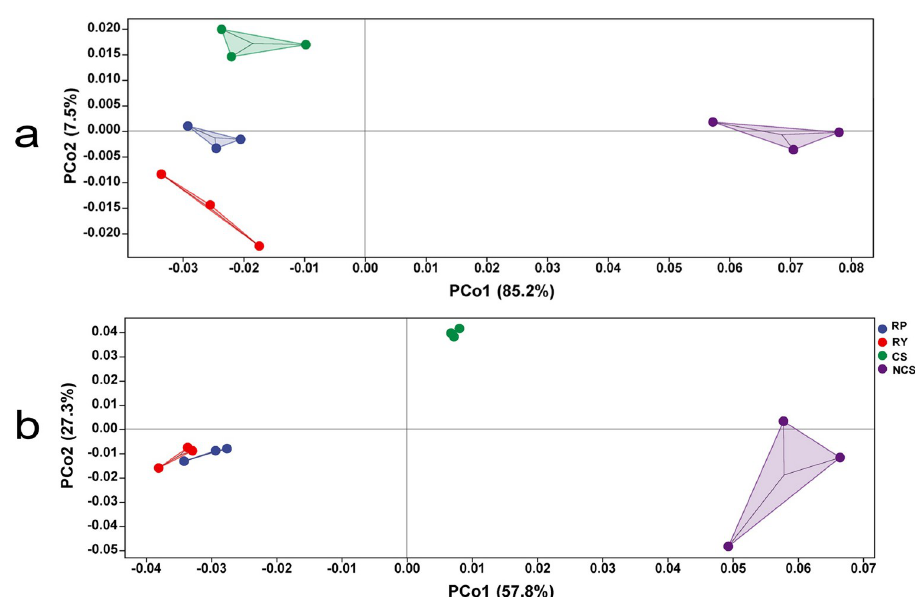
Fig 5. PCoA of fungi (a) and bacteria (b). Using the normalized functional unit abundance table (abundance sum of 1 M per sample), the distance matrix was calculated and PCoA analysis was performed by R Script. The percentage in the brackets on the axis represents the proportion of the sample variation that can be